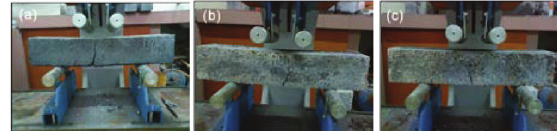
Fig. 6. Flexural failure of S1/50 (a); S2/50 (b); and S3/50